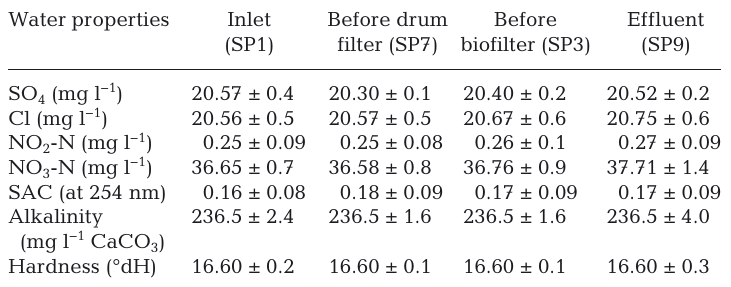
Table 3. Mean (±SD) values of physicochemical water properties of samples collected before the first trial (control diet), in between trials when the diets were changed and after the second trial (cork diet) at different locations within the system (sampling points, SP; see Fig. 1; n = 6 samples per location). SAC: spectral absorption coefficient ; °dH: German degree of